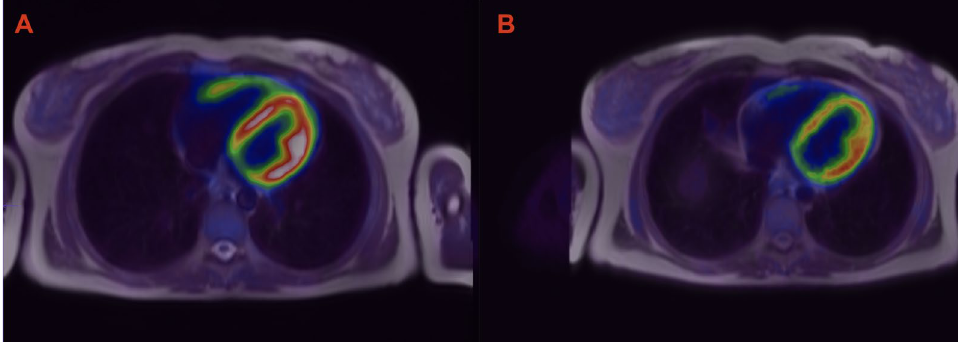
Fig. 2 Cardiac 18-fluorodeoxyglucose uptake in pulmonary hypertension patient before A initiation of specific therapy and after B 24 months of